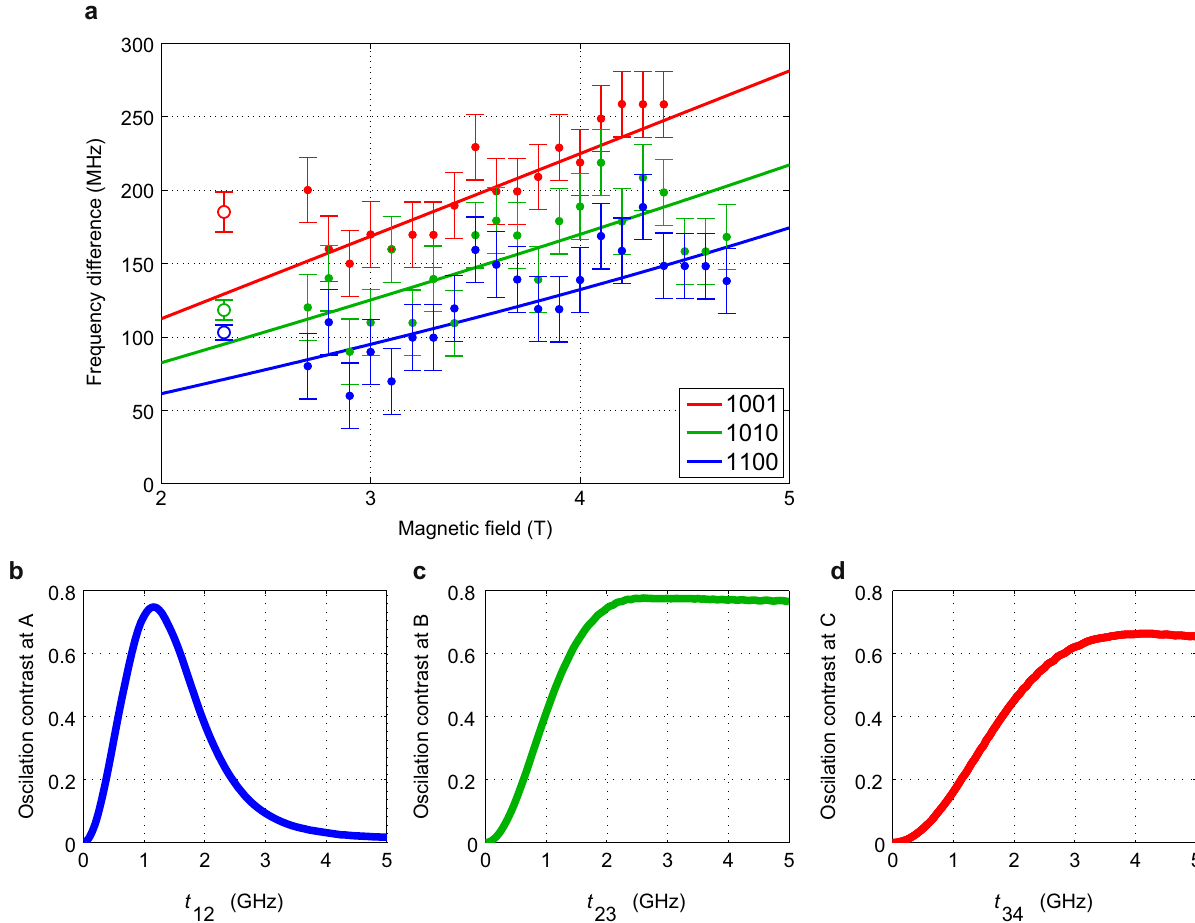
Fig. 4 Zeeman energy differences and simulated S - T 0 oscillation contrasts. a The Zeeman energy in each dot is determined using EDSR ¼ (cid:4) 0 : 4332±0 : 0005 , measurements for a range of magnetic fi eld strengths 28, 34 and is fi tted to E z = | g 1 μ B B + g 3 μ B B 3 | , resulting in g dot1 1 Þ 10 (cid:4) 3 /T 2 . The solid data points represent the differences in Zeeman energy between dot n ( n = 2,3,4) and dot 1 as a function of magnetic fi eld, extracted from the EDSR measurements (error bars account for the expected fl uctuations of ± 15 MHz from the quasi-static nuclear fi eld and ± 5 MHz from the frequency resolution of the measurement, for each of the two resonance measurements used in the frequency difference calculation). Solid curves represent the difference between the fi t of dot n and dot 1. Open circles show the Zeeman energy differences extracted from Figs. 3a – c (error bars indicate the fi tting uncertainty). b The contrast of the simulated coherent oscillation when pulsing from point I to point A in Fig. 1b. The simulation assumes a linear ramp from start to end over 2.50 ns. c Similar to b but pulsing to point B and varying the tunnel coupling between dots 2 and 3. d Similar to b but pulsing to point C and varying the tunnel coupling between dots 3 and 4. The tunnel couplings were set to t 12 = 1.2, t 23 = 2.6, and t 34 = 4.3 GHz if not varied. These values correspond to the peak positions in the tunnel coupling dependencies. Note that the maximum in d is lower and occurs for a higher tunnel coupling than that in c because the ramp rate is higher for d (same ramp duration but higher pulse